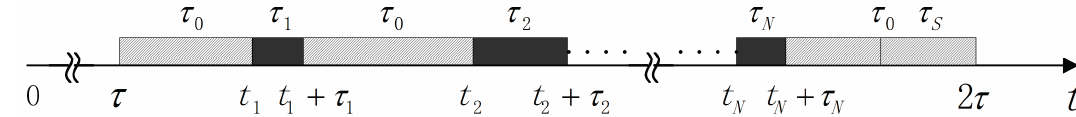
Figure A1. The ordering of